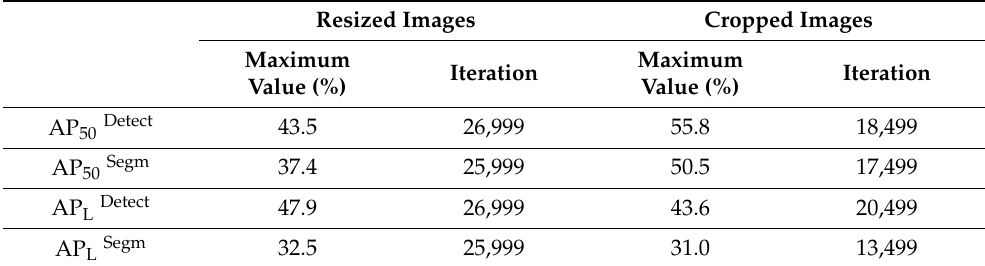
Table 3. Metrics values for models based on resized and cropped images for the validation